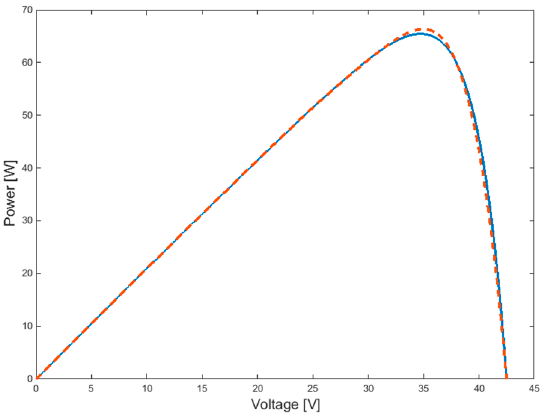
Figure 10. Power ‐ voltage (P ‐ V) curve for the photo ‐ voltaic (PV) module of Table 1 in environmental conditions (ECs) “Third” of Table 2. I ‐ V curve of the proposed model (solid line) and I ‐ V curve of the datasheet (dotted line).